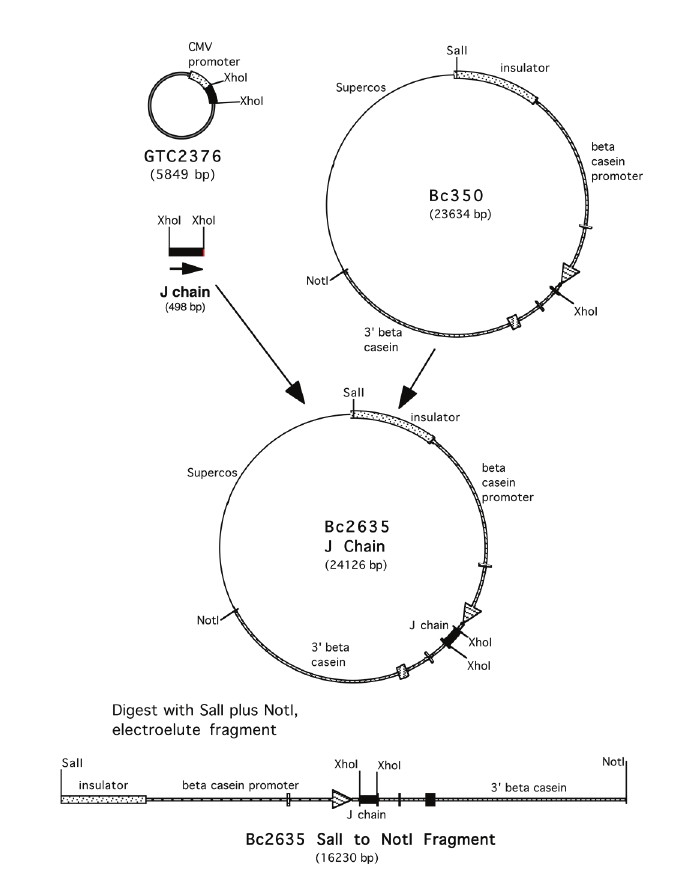
Supplementary Figure 3. Construction of BC2635 J chain. The J chain in the pcDNA3 vector, 2365 was obtained from L. Cavacini. It has the native sequence found in UniProtKB: P01591.4. The XhoI fragment containing the gene was cloned into the XhoI site of BC350 to yield BC2635 J